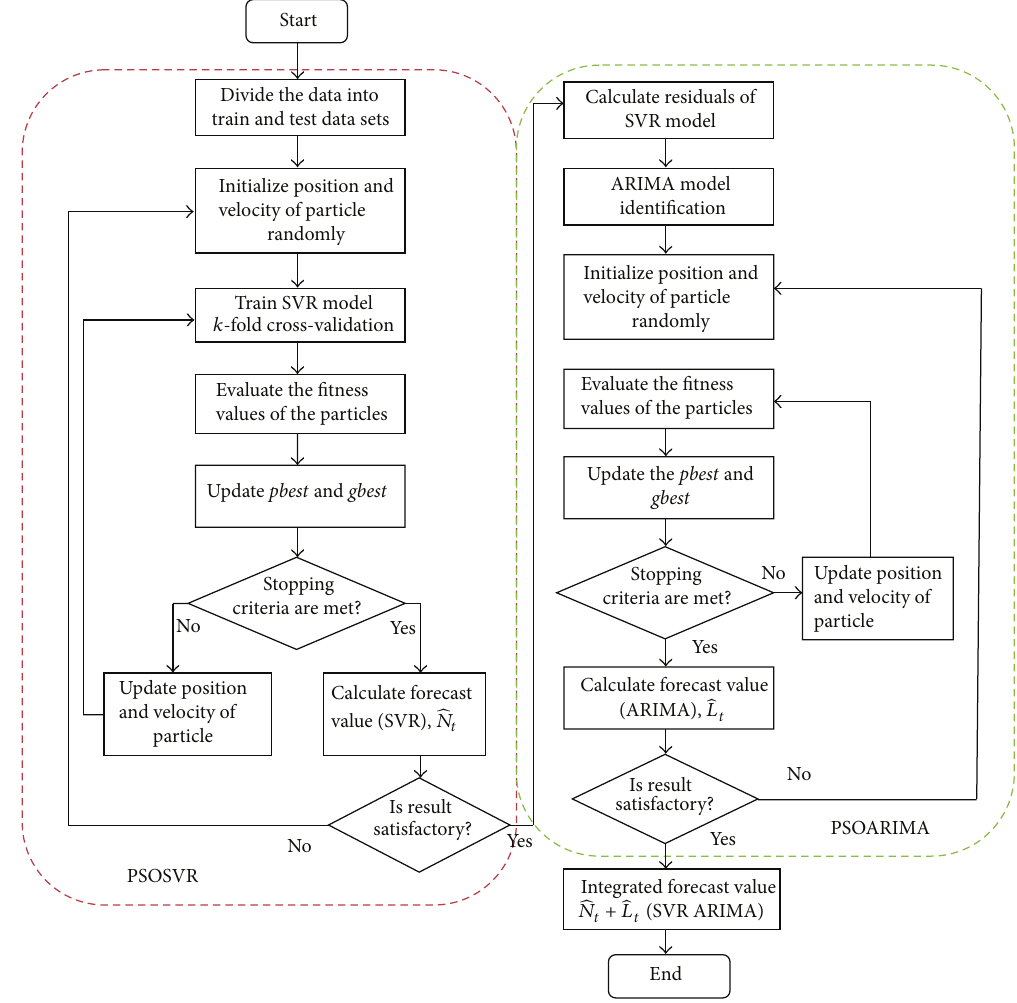
Figure 1: The Flow chart for the proposed hybrid PSOSVR and PSOARIMA